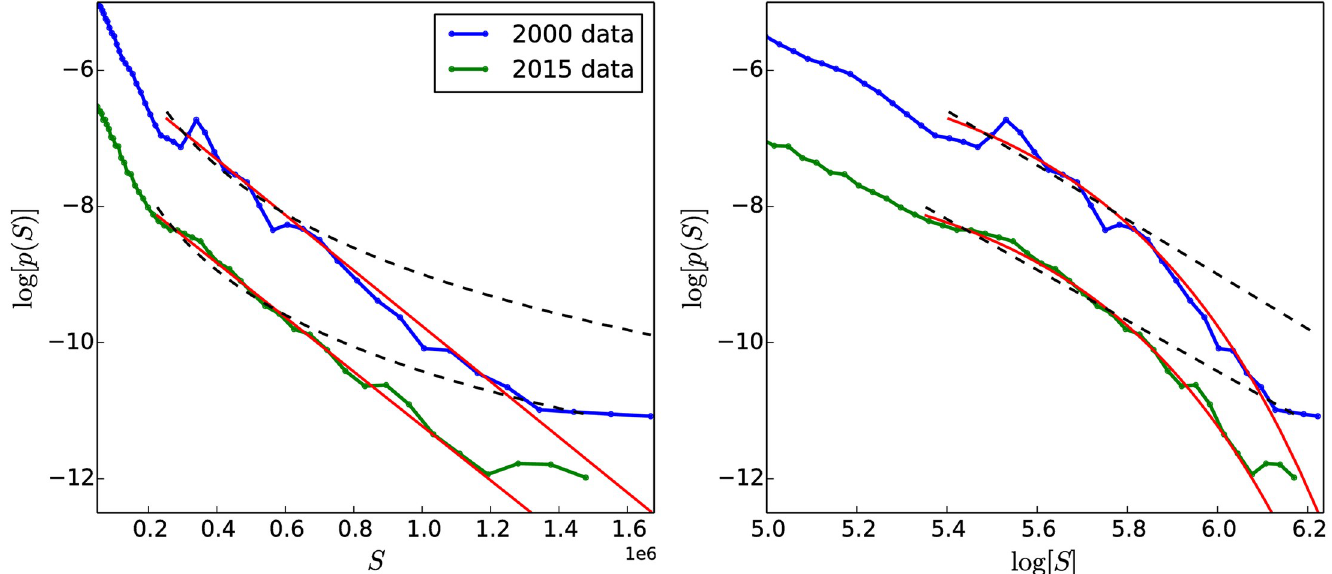
Fig 11. Functional form of high-income tail of USA household income distribution. Power-law (dashed black line) and exponential (solid red line) distributions with lower and upper bounds on the fitted distribution chosen to correspond to the full high-income tail. S represents USA household income data in 1999 USD. The curves for 2015 have been shifted down in the plots for better